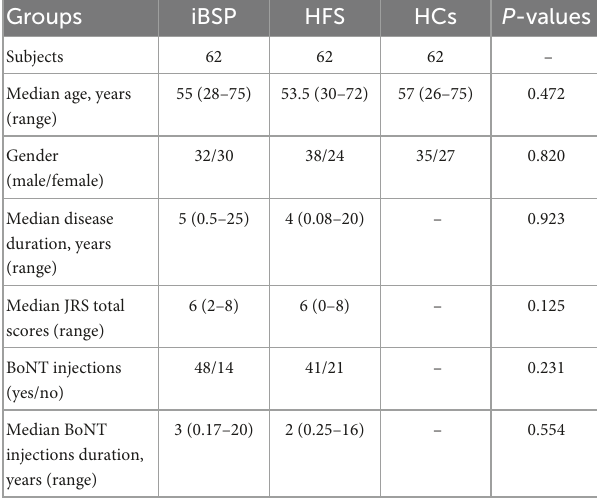
TABLE 1 Subjects’ demographics and clinical